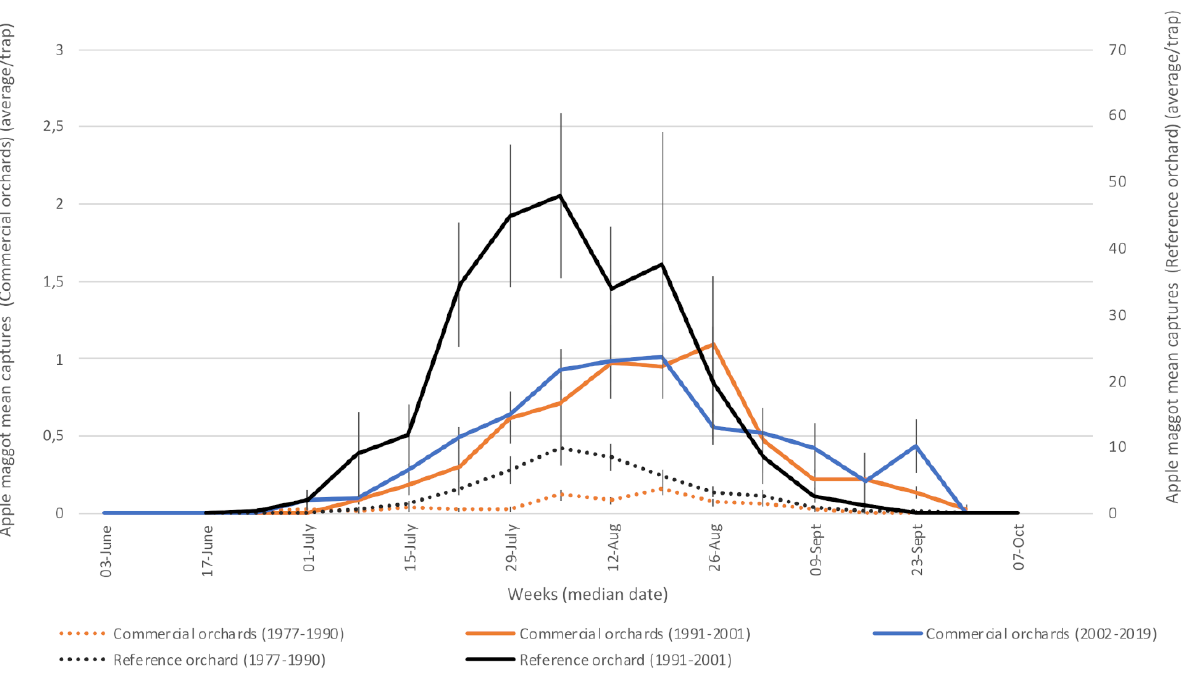
Figure 7. Average captures of adult apple maggot in participating orchards. Reference (insecticide-free) orchard located at Frelighsburg, Qc (Agriculture and Agri-Food Canada, 1977–2001). Commercial orchards located at Franklin, Hemmingford, Oka, Rougemont and Saint-Paul-d’Abbotsford. Vertical bars represent standard